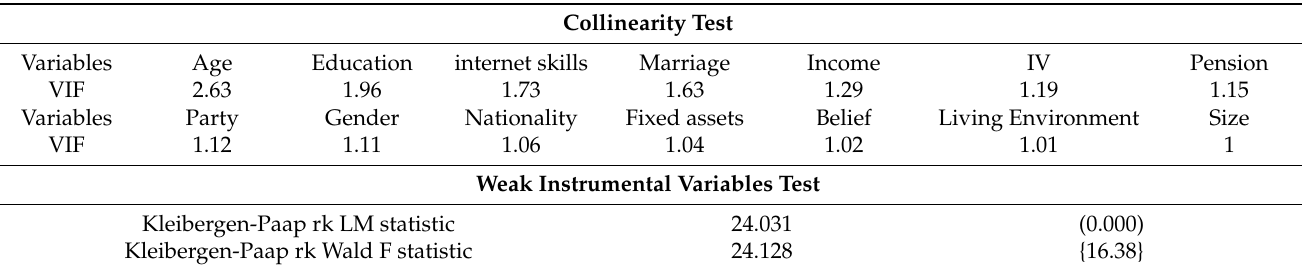
Table 3. Collinearity test and weak instrumental variables test. Collinearity Test